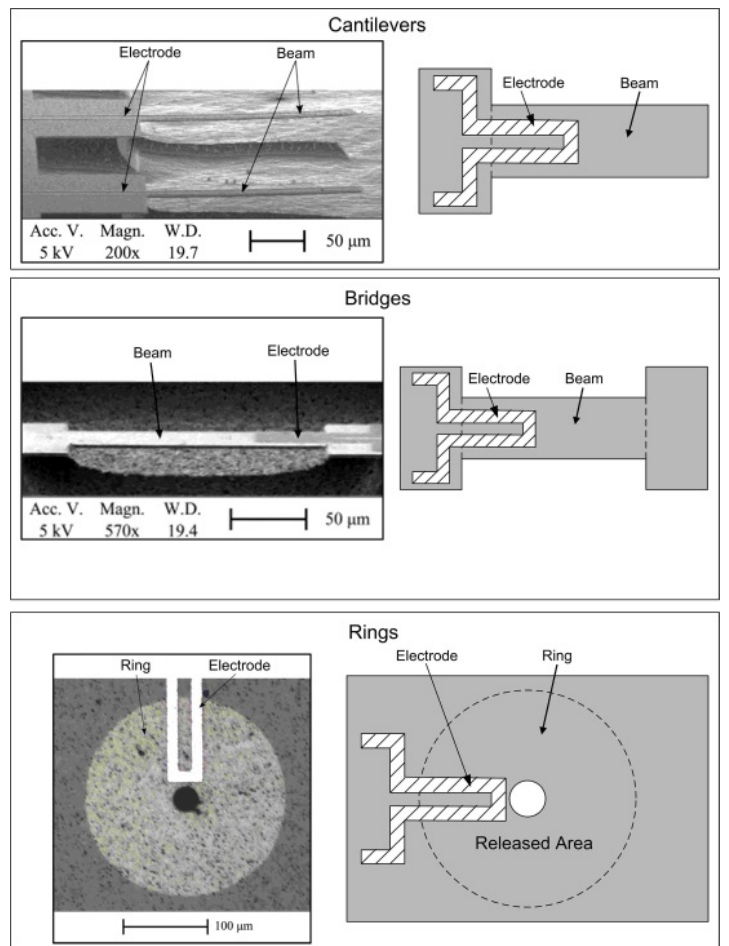
Figure 6. Scanning electron microscopy (SEM) images of electrothermally-actuated SiC